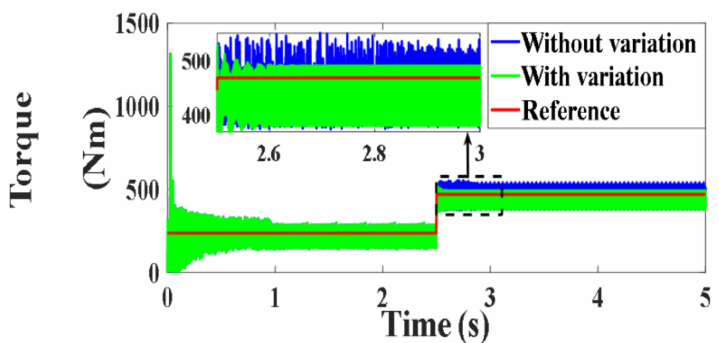
Figure 147. Developed torque under PVC (Nm).